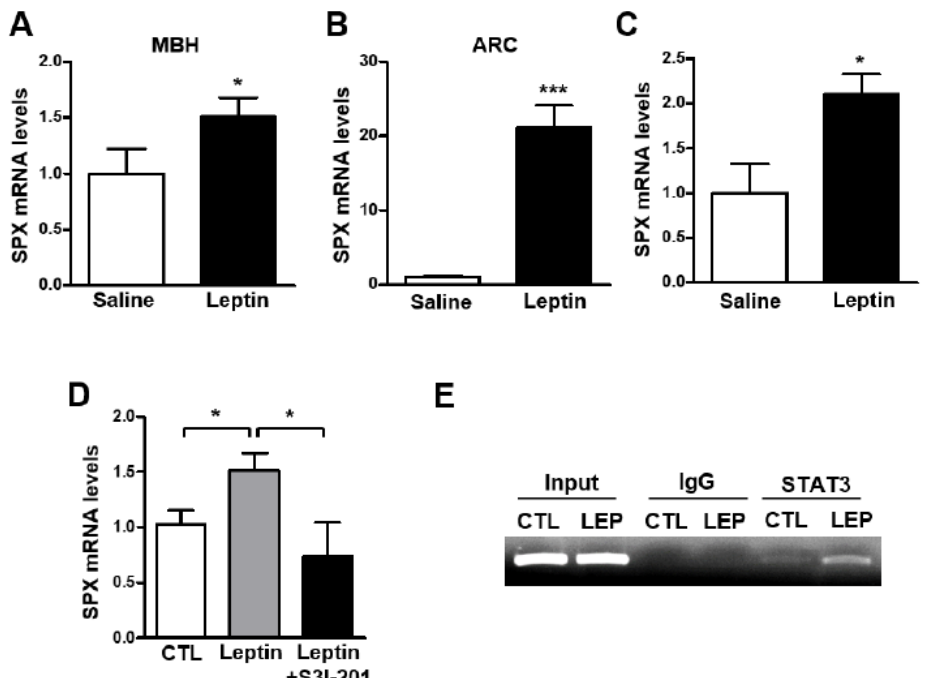
Figure 2. Effect of leptin on SPX expression via STAT3 activation. To determine the effect of leptin on SPX expression, eight-week-old male mice were fasted for 24 h and icv-injected with leptin (2.5 μg); tissue samples were collected 1 h after leptin injection. ( A , B ) Total RNA was isolated from the mediobasal hypothalamus (MBH) (A) and arcuate nucleus (ARC) ( B ) and analyzed with qRT-PCR. ( C ) Leptin was icv-injected into ObRb-Cre; Rpl22 HA mice to analyze leptin-induced SPX mRNA level in ObRb-expressing cells. SPX mRNA was determined using qRT-PCR of MBH RNA samples immunoprecipitated with HA antibody. ( D ) Mice were icv-injected with 100 µ M of S3I-201, an inhibitor of STAT3 activation, and then after 3 h, icv-injected with leptin. After 1 h, MBH SPX mRNA was analyzed by qRT-PCR. ( E ) ChIP assays were performed to verify whether STAT3 directly binds to the SPX promoter and whether leptin affects this binding. Mice were icv-injected with either saline (CTL) or leptin (LEP) and nuclear DNA samples from their MBH were immunoprecipitated with anti-STAT3 antibody or mouse IgG. Immunoprecipitates were analyzed by PCR amplification using a primer set specific to the mouse SPX promoter. Input represents the DNA extracted from the mouse MBH before immunoprecipitation. Data are presented as mean ± S.E.M. *, p < 0.05; ***, p <